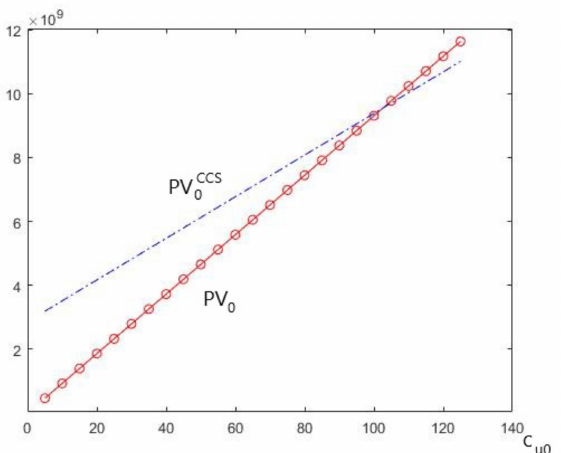
Figure 4. Threshold value c ∗ of price of CO 2 emission allowance determined based on patterns of u 0 PV 0 and PV CCS for r = 8% for the case 1 (30% carbon capture) (Source: own work). 0